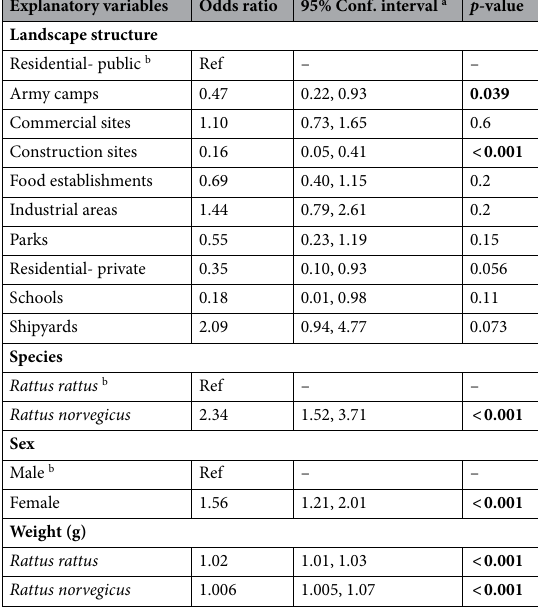
Table 4. Bivariable logistic regression analysis for Seoul hantavirus antibody detection in Rattus rattus and Rattus norvegicus . Significant values ( P < 0.05) are shown in bold. a 95% Confidence Interval. b Reference